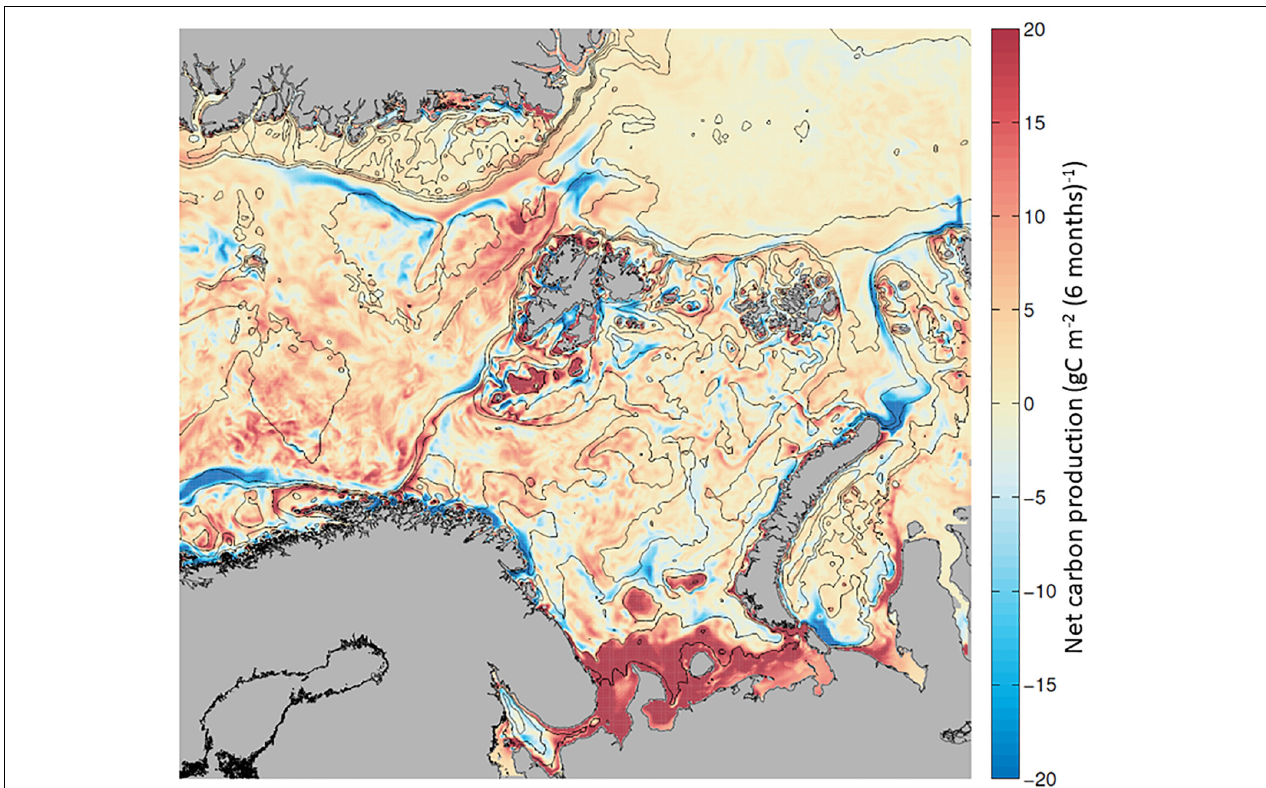
FIGURE 7 | Net carbon production (NCP), calculated as the balance between in situ production (GPP) and in situ carbon losses (respiration, DOC excretion, sinking and grazing), calculated for each grid cell and mapped. Positive NCP (in red) and net carbon losses (in blue) from + 20 to –20 g C m − 2 6mo − 1 , between April and September